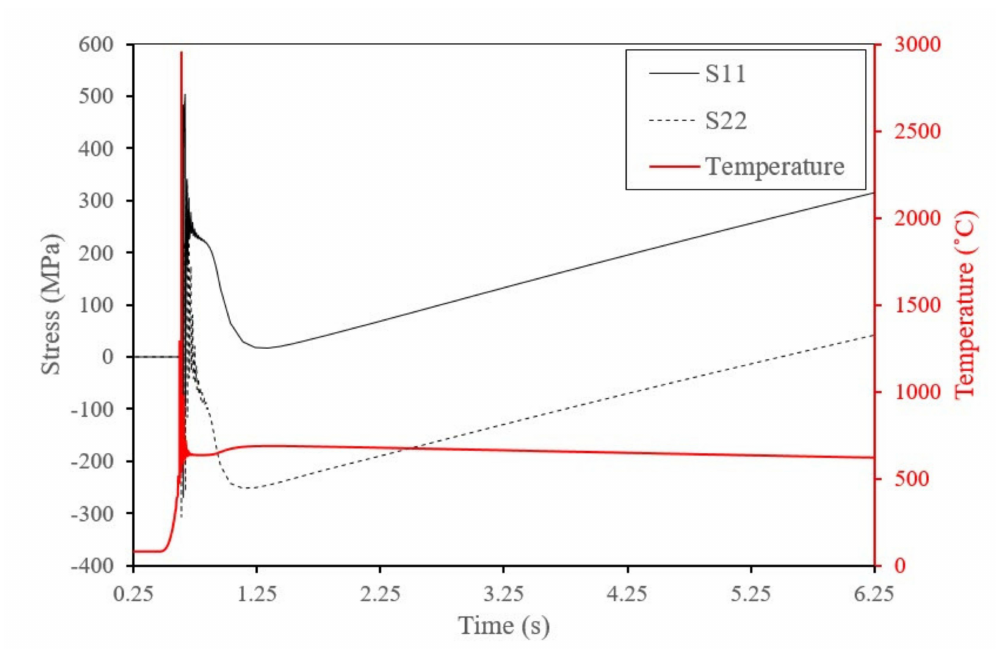
Figure 18. Layer stress and temperature evolution at 220 W, 650 mm/s, and 0.12